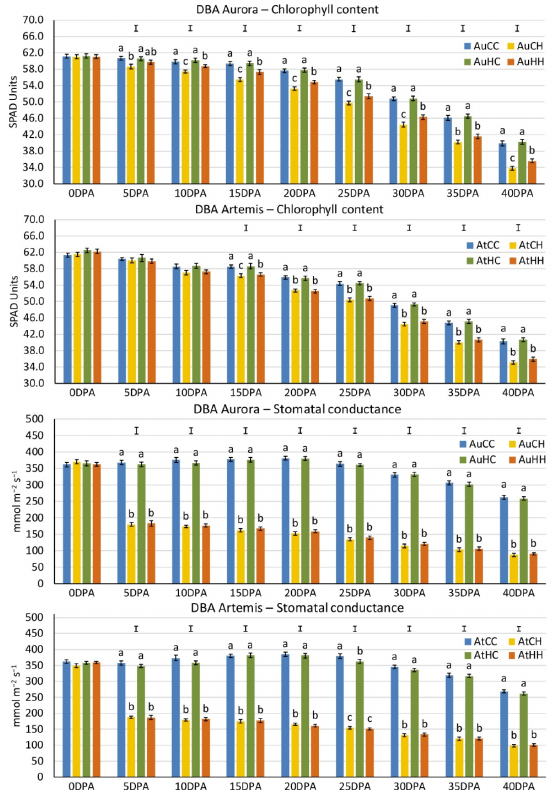
Figure 1. Flag leaf chlorophyll content and stomatal conductance (adaxial) measured from flowering to 40 days post-anthesis (DPA) in two durum wheat varieties. Means are shown with standard error ( n = 8 for chlorophyll content, n = 4 for stomatal conductance). The capped lines show the LSD (Least Significant Difference) values at p = 0.05 for measurements taken at each time-point. The letters (a, b, c) indicate significant statistical difference ( p < 0.05) across treatment groups at each time- point. The treatment groups are: AuCC (DBA Aurora progeny treated with the control, originated from control group parents), AuCH (DBA Aurora progeny treated with heat stress, originated from control group parents), AuHC (DBA Aurora progeny treated with the control, originated from heat stress group parents), AuHH (DBA Aurora progeny treated with heat stress, originated from heat stress group parents), AtCC (DBA Artemis progeny treated with the control, originated from control group parents), AtCH (DBA Artemis progeny treated with heat stress, originated from control group parents), AtHC (DBA Artemis progeny treated with the control, originated from heat stress group parents), AtHH (DBA Artemis progeny treated with heat stress, originated from heat stress group